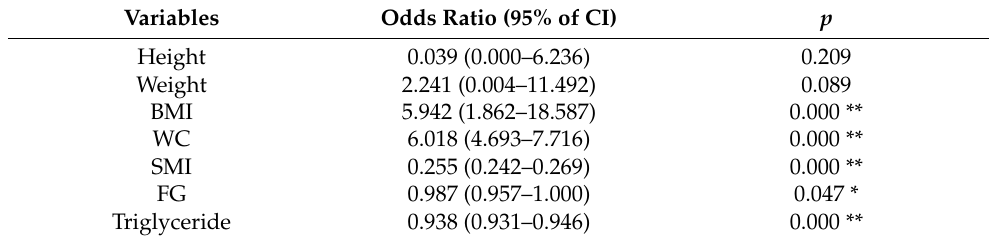
Table 4. Odds ratio for SO in males.